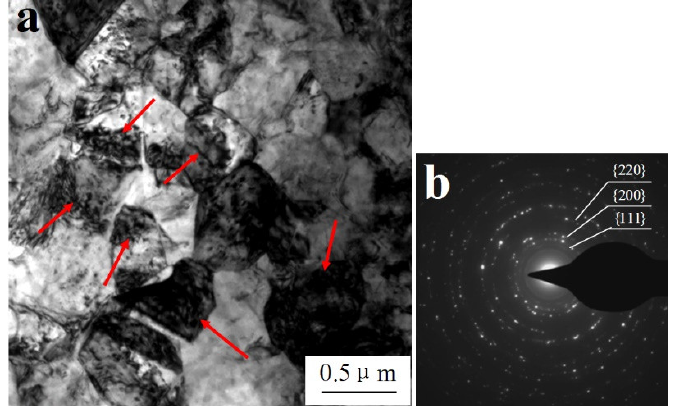
Figure 7. Recrystallized grains in the Cu matrix of W f /Cu 82 Al 10 Fe 4 Ni 4 composites: ( a ) recrystallized grains and ( b ) SADP of recrystallized grains.